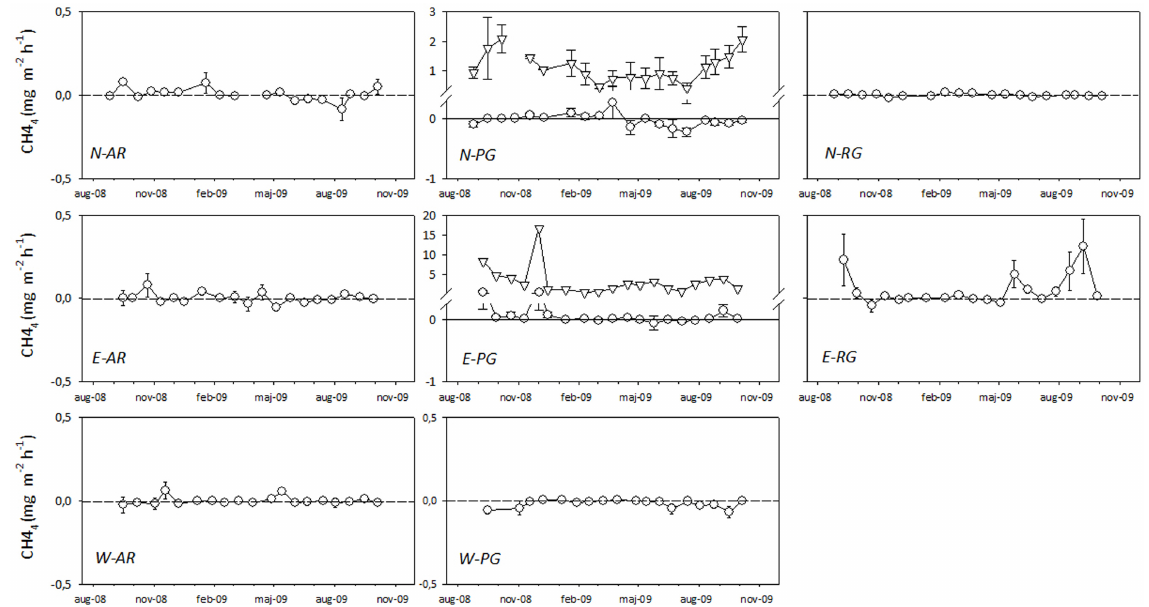
Fig. 9. Seasonal variations in CH 4 fluxes at the eight monitoring sites; for information about site ID, see legend to Fig. 2. One data set from April 2009 at site N-AR was omitted due to unresolved analytical problems. At sites N-PG and E-PG there were a few sampling points, with tussocks of J. effusus (soft rush) that showed consistent emissions of CH 4 . Circles represent mean ± standard error ( n = 6 at sites without